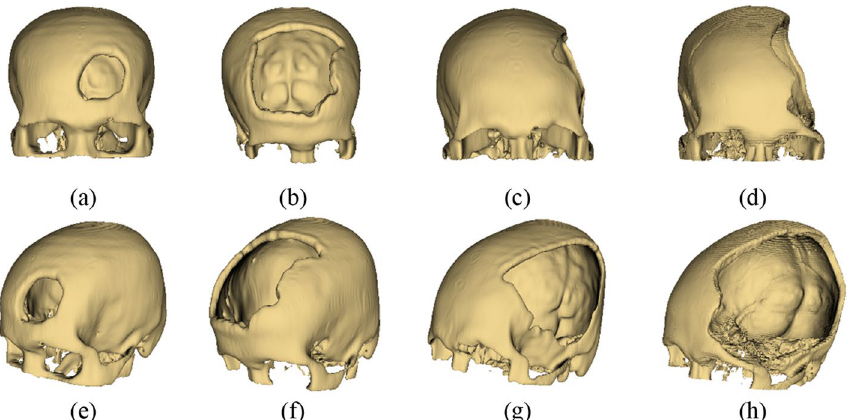
Figure 1. Frontal and perspective views of the 3D reconstructed skull models of the four patients whose defects appear on four locations. The top row ( a ) and ( b ) illustrates the frontal defect cases while ( c ) and ( d ) depicts parieto-temporal defect cases. The bottom row ( e ) to ( h ) represents the perspective views of cases ( a ) to ( d ). Note that the four cases were named as case A, B, C and D corresponding to ( a ), ( b ), ( c ) and ( d ) respectively.